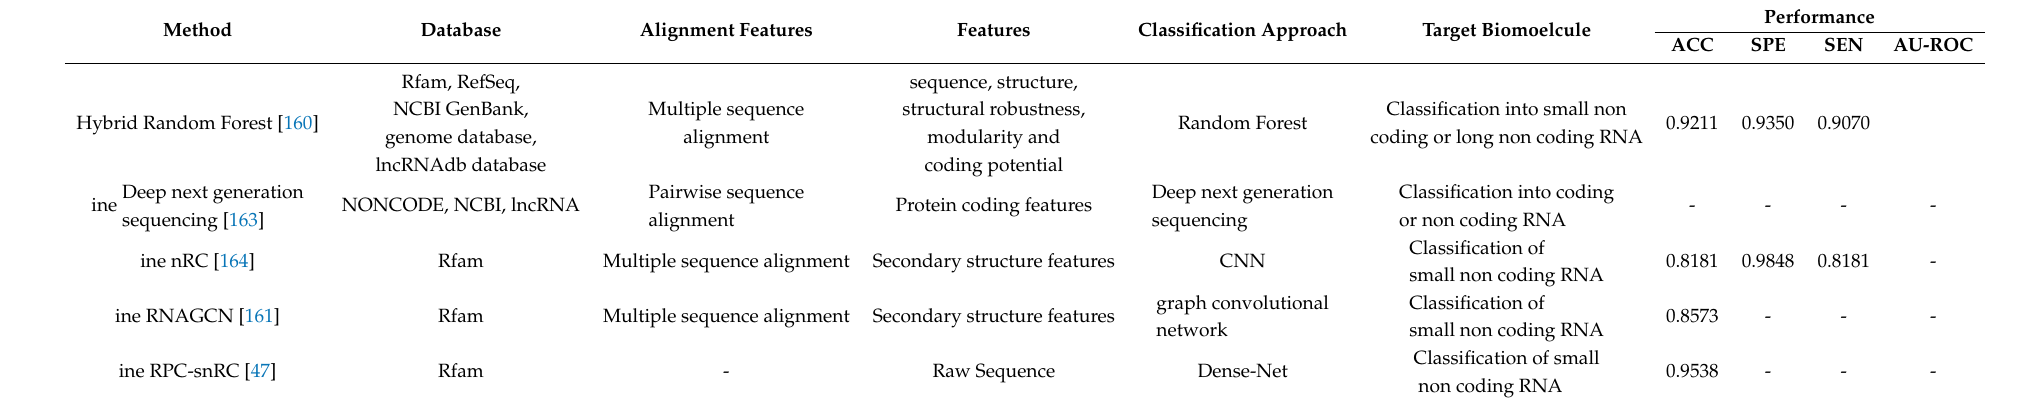
Table 6. A brief summary of computational methodologies developed for small non-coding RNA family